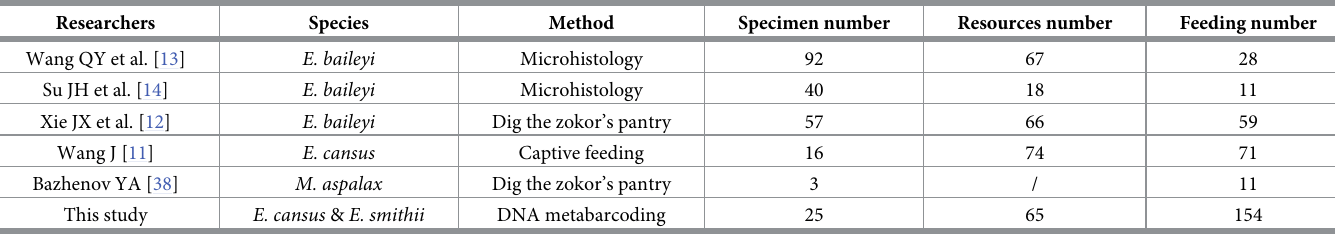
Table 5. Comparison of zokor diet